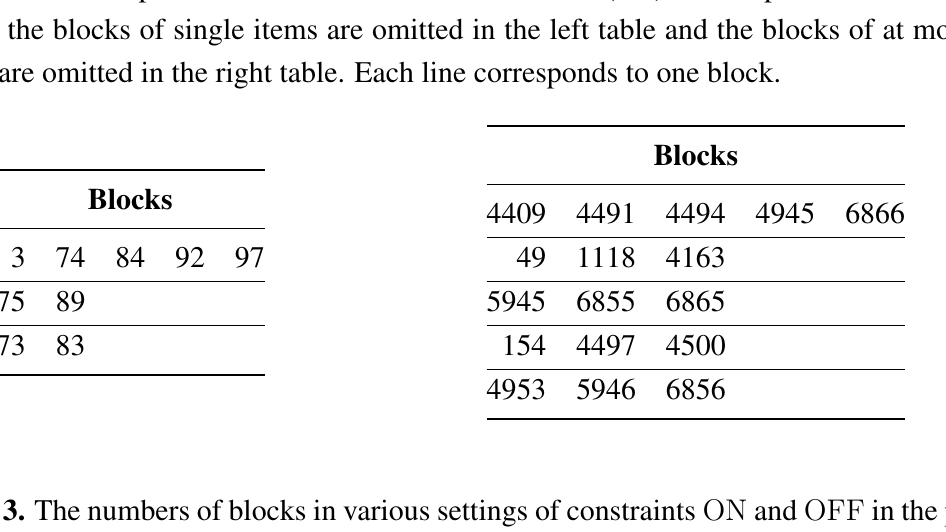
Table 3. The numbers of blocks in various settings of constraints ON and OFF in the pumsb dataset. In the left table, each line in the first column contains one item chosen at random for ON , where OFF = ∅ ; in the right table, each line in the first column contains five items chosen at random for OFF , where ON = ∅ . Items are shown as original pumsb item